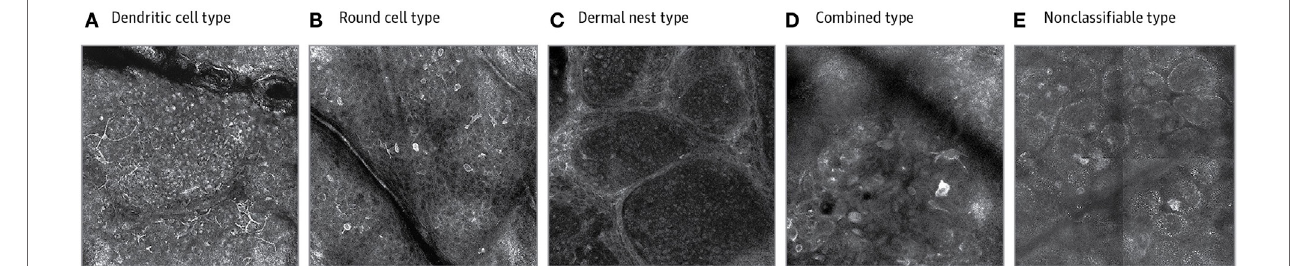
FigURe 3 | Reflectance confocal microscopy has allowed for sub-classification of melanomas using morphological descriptions. Permissions obtained to reprint from Grazziotin et al. (70). In their study, it was found that dendritic cell melanomas (a) were linked to more sun exposure and round cell melanomas (B) occurred in patients with familial melanomas and fairer skin. Dermal nest (C) and combined (D) melanomas were associated with a lack of pigmented network on dermoscopy and thicker tumours on histology. The morphological expression can also be linked to tumor behavior, for example, the non-classifiable type (e) had less atypia on basal layer melanocytes and had lower asymmetry, border, color, dermoscopic structures (ABCD rule in dermoscopy) scores using dermoscopy.